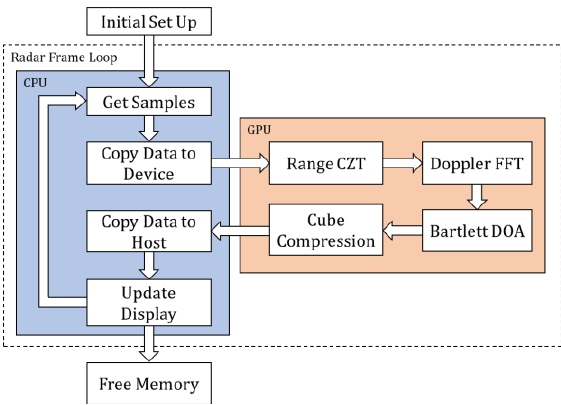
Fig. 7. Implementation of Proposed Algorithm